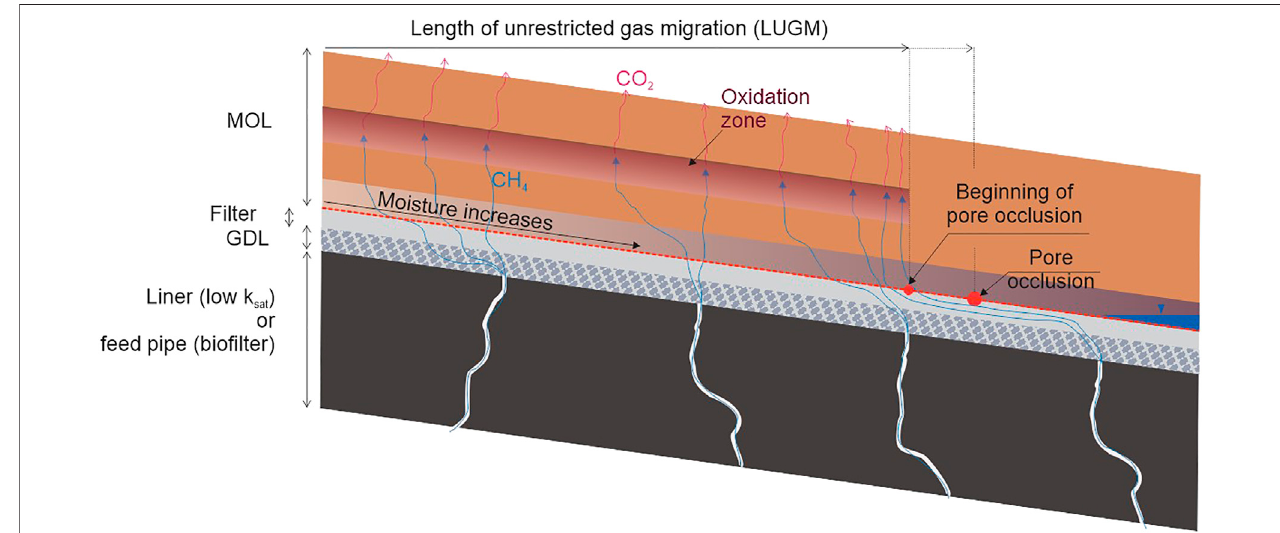
FIGURE 7 | Schematic representation of the Length of Unrestricted Gas Migration